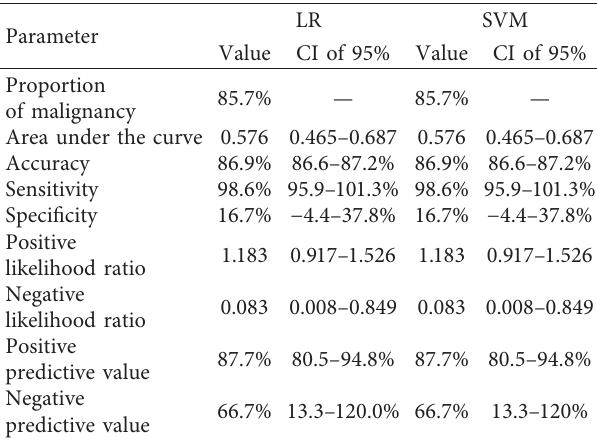
Table 5: Performance of the classifiers based on the two common algorithms of machine